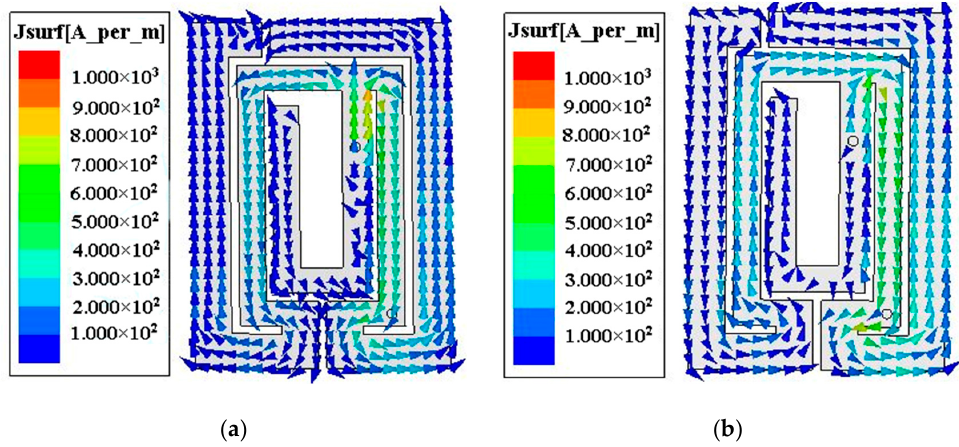
Figure 3. Current distributions of the proposed antenna at ( a ) 391 MHz; ( b ) 412 MHz.